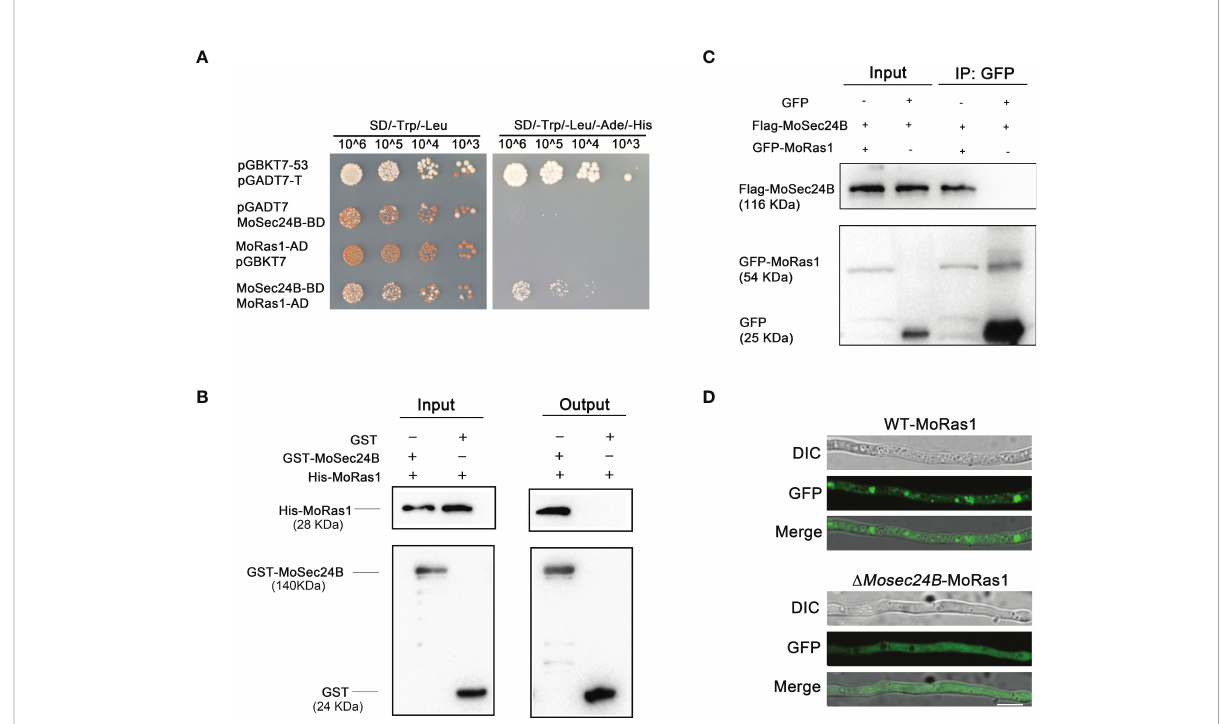
FIGURE 6 (A) Interaction between MoSec24B and MoRas1 was detected using a yeast-two-hybrid assay. pGBKT7-53 and pGADT7-T were used as positive controls, and pGBKT7 and pGADT7 were used as negative controls. (B) Interaction between MoSec24B and MoRas1 was examined using a pull- down assay. GST-MoSec24B and His-MoRas1, empty GST- and His-MoRas1 were incubated sequentially with glutathione agarose gel beads with GST labels for two hours, respectively. The fi nal eluate obtained was detected by immunoprecipitation. (C) Interaction between MoSec24B and MoRas1 was detected using a co-IP assay. MoRas1-GFP and MoSec24B-Flag, empty GFP and MoSec24B-Flag were incubated with anti-GFP beads for four hours, respectively. The fi nal eluate obtained was detected by immunoprecipitation. (D) Subcellular localization of MoRas1 in the wild-type and the D Mosec24B mutant mycelium. Scale Bar = 10 m